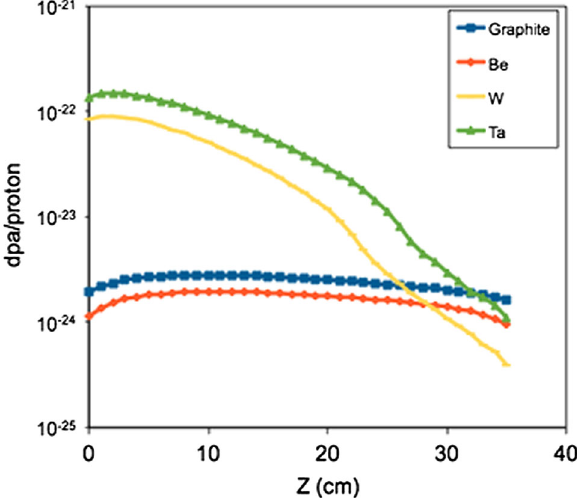
FIG. 7 (color online). Variations of the total helium production with target depth for different materials.